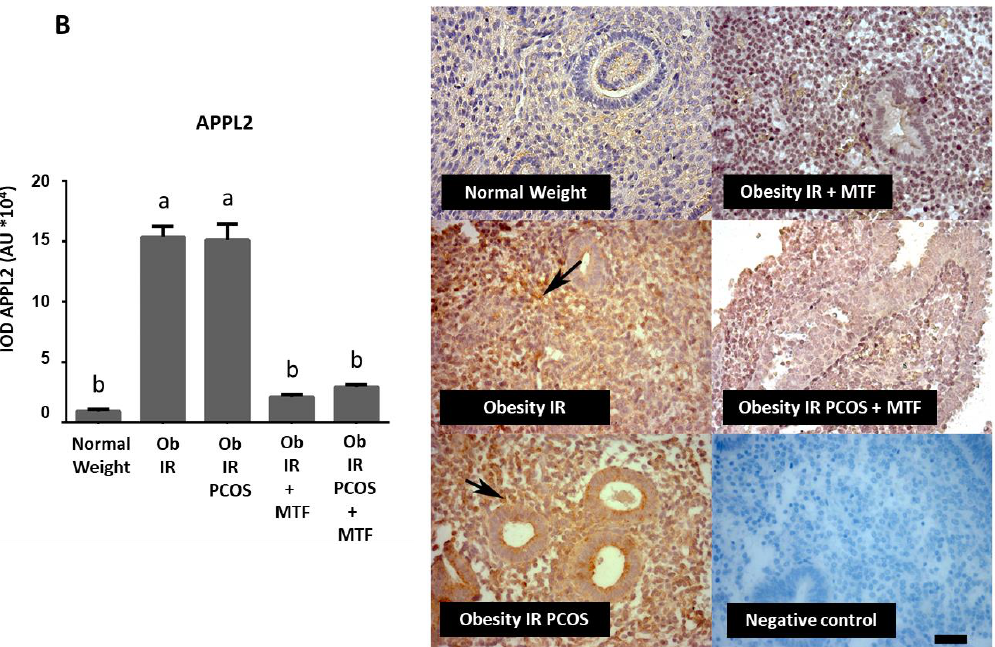
Figure 2. Effect of metformin on expression levels of molecules associated with adiponectin signal- ing in endometria from women with insulin resistance, obesity and PCOS. APPL1 protein ( A ) and APPL2 protein ( B ) levels in endometria from the study groups were determined by IHC ( n = 7 sam- ples in each group): Normal Weight group (control group), Obesity+IR group, Obesity+IR+PCOS group, Obesity+IR group treated with metformin (MTF) and Obesity+IR+PCOS group treated with MTF. MTF treatment: 850 mg twice a day for at least 12 weeks. Photomicrographs show the tissue location of APPL1 (in ( A )) and APPL2 (in ( B )) by immune-positive brown color staining in each sample (arrows). The graphs show the semi-quantification of each protein level in endometrial tis- sue obtained by the IOD tool. Negative control: tissue samples in the absence of primary antibody. Bar = 50 μm; images at 400×. In the graph, a ≠ b ≠ c indicates a statistically significant difference with a p -value < 0.05; non-parametric test and Dunn’s post hoc test. Data are shown as mean AU (arbi- trary units *10 4 ) ± SEM.